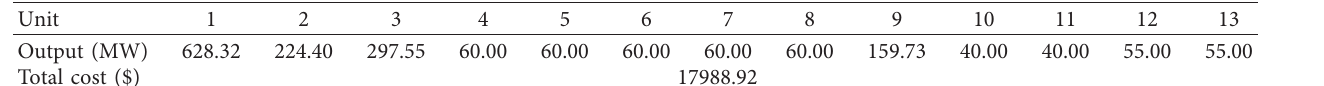
Table 8: Best dispatch obtained by ISSO for 13-unit system with P